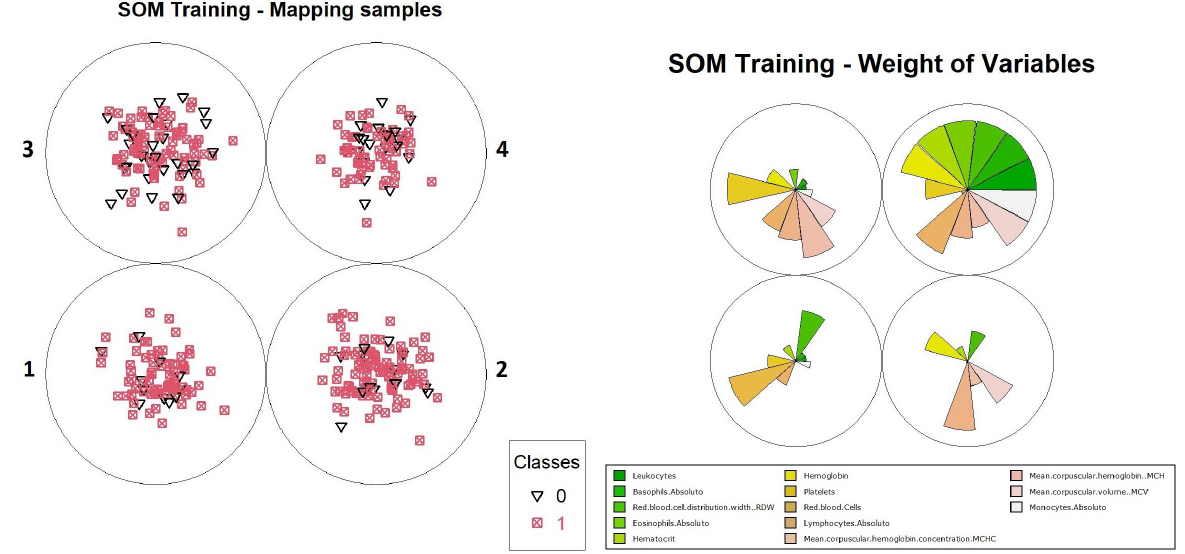
Figure 18. Distribution of objects and weights per neuron—level 2 TESSOM